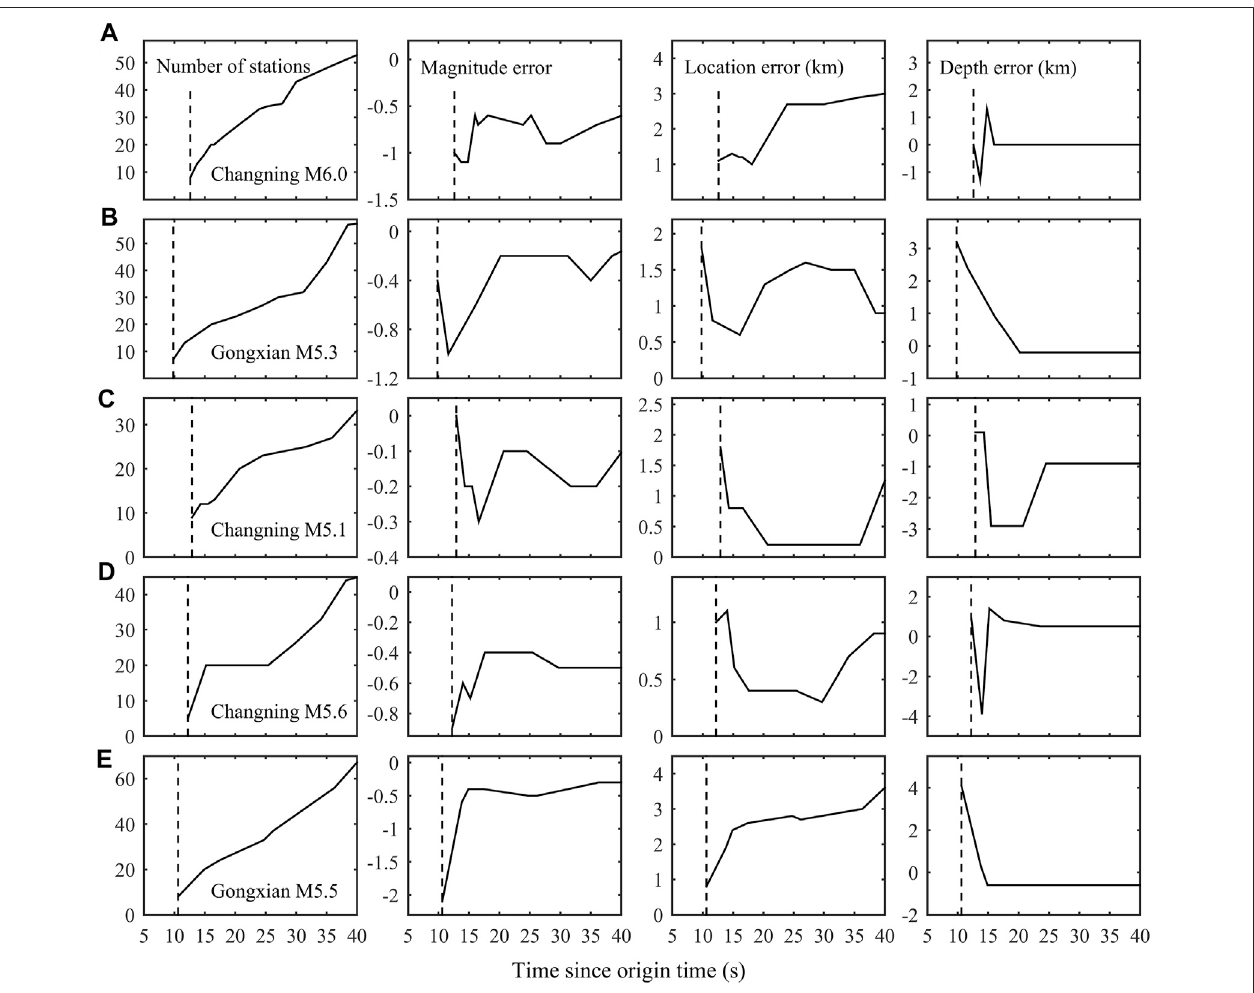
FIGURE 5 | Real-time processing results of JEEWS for fi ve M5.0 + earthquakes occurring in the Changning seismic sequence. (A) Changning M6.0 (2019/06/17 22:55:44); (B) Gongxian M5.3 (2019/06/17 23:36:04); (C) Changning M5.1 (2019/06/18 07:34:33); (D) Changning M5.6 (2019/06/22 22:29:56); (E) Gongxian M5.5 (2019/07/0410:17:58).Fromlefttoright,eachpanelisthenumberoftriggeredstations,themagnitudeerror,thelocationerror,andthedeptherrorasafunctionoftime, respectively. Vertical lines indicate the fi rst alert time.